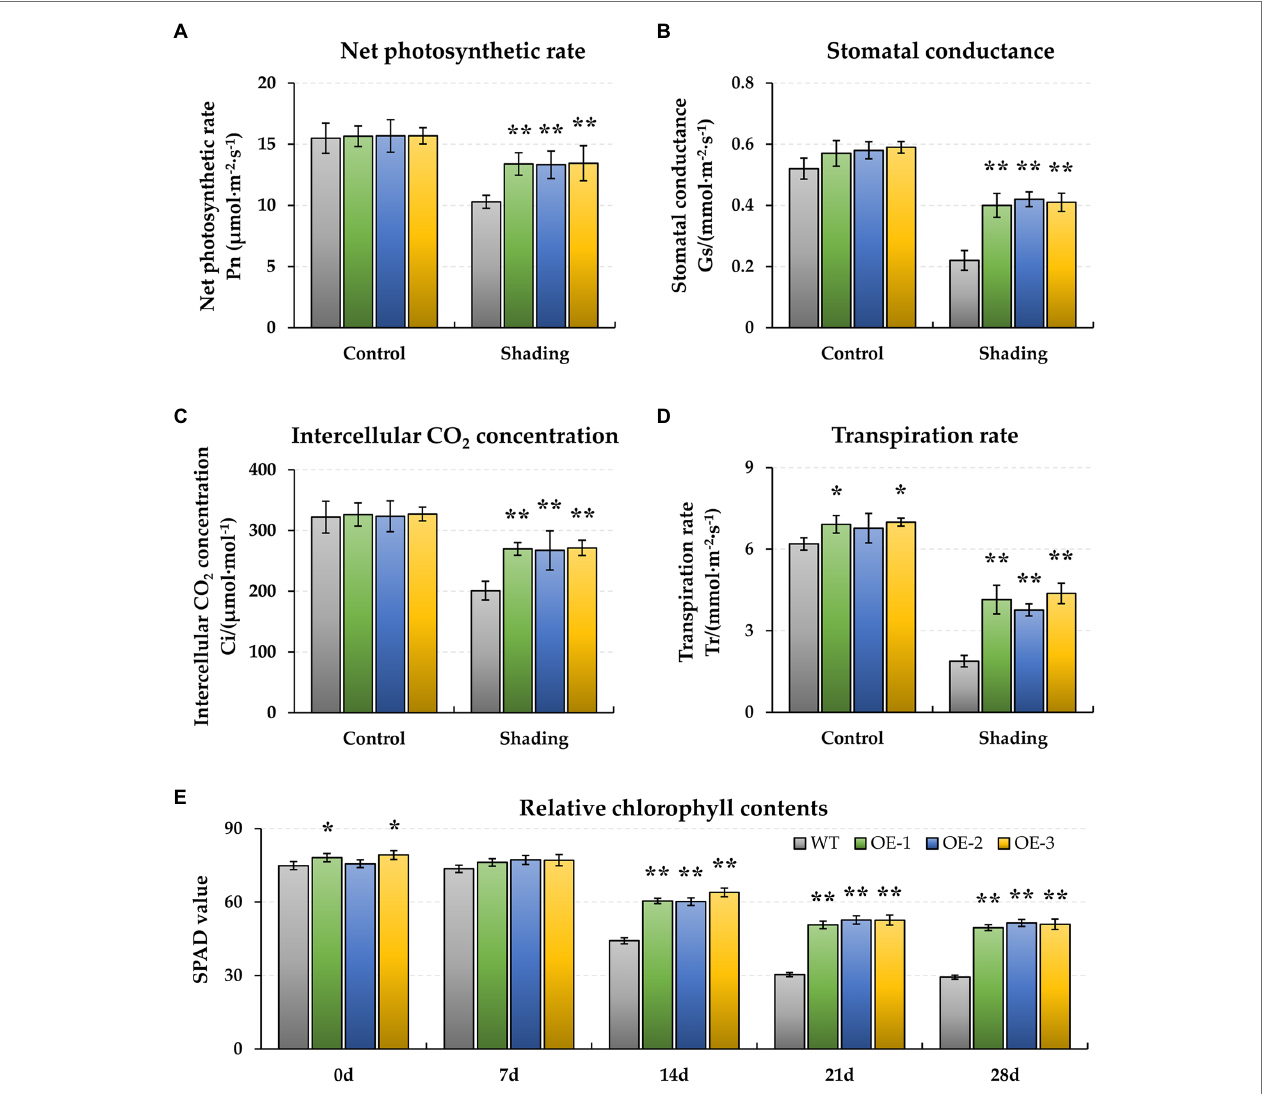
FIGURE 1 | Effect of shading stress on the physiological photosynthesis and pigment of wild type (WT) and BnaMAPK1 -overexpressing ( BnaMAPK1 -OE) transgenic rapeseed. (A) Net photosynthetic rate (Pn). (B) Stomatal conductance (Gs). (C) Intercellular CO 2 concentration (Ci). (D) Transpiration rate (Tr). (E) Relative chlorophyll contents (SPAD). The physiological parameters (Pn, Gs, Ci, and Tr) were measured under normal light (control) and shading conditions at 0 and 28 days each, and the chlorophyll content (SPAD) at 0, 7, 14, 21, and 28 days each. Vertical bars are means of three replicates ± SD (three plants of each line, three leaves of each plant, and 10 times of each leaf were measured); asterisk and double asterisk indicate p-value < 0.05 and p-value <